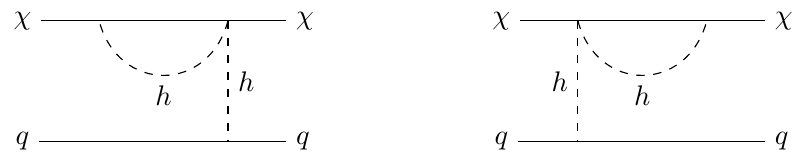
Figure 12 . Additional loop diagrams within the CP-violating Higgs portal model which also induce purely spin-independent interactions for (cid:30) = (cid:25)= 2.